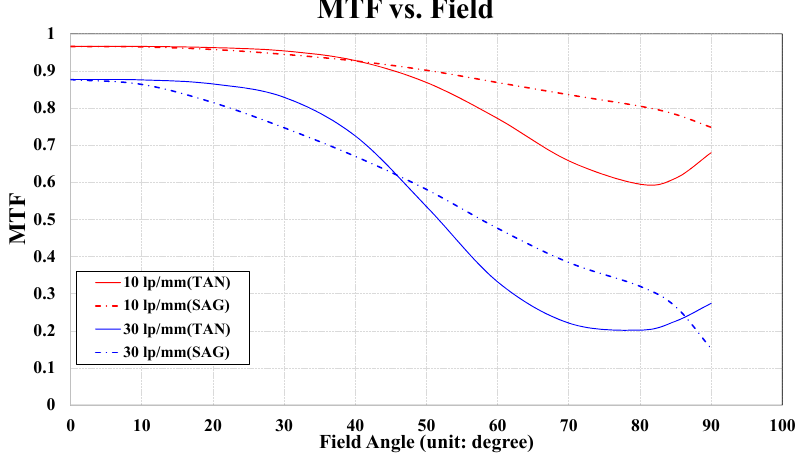
Figure 4. Field MTF plots for the optimized fisheye lens system (“lp” represents “line pair,” the units of spatial frequency).